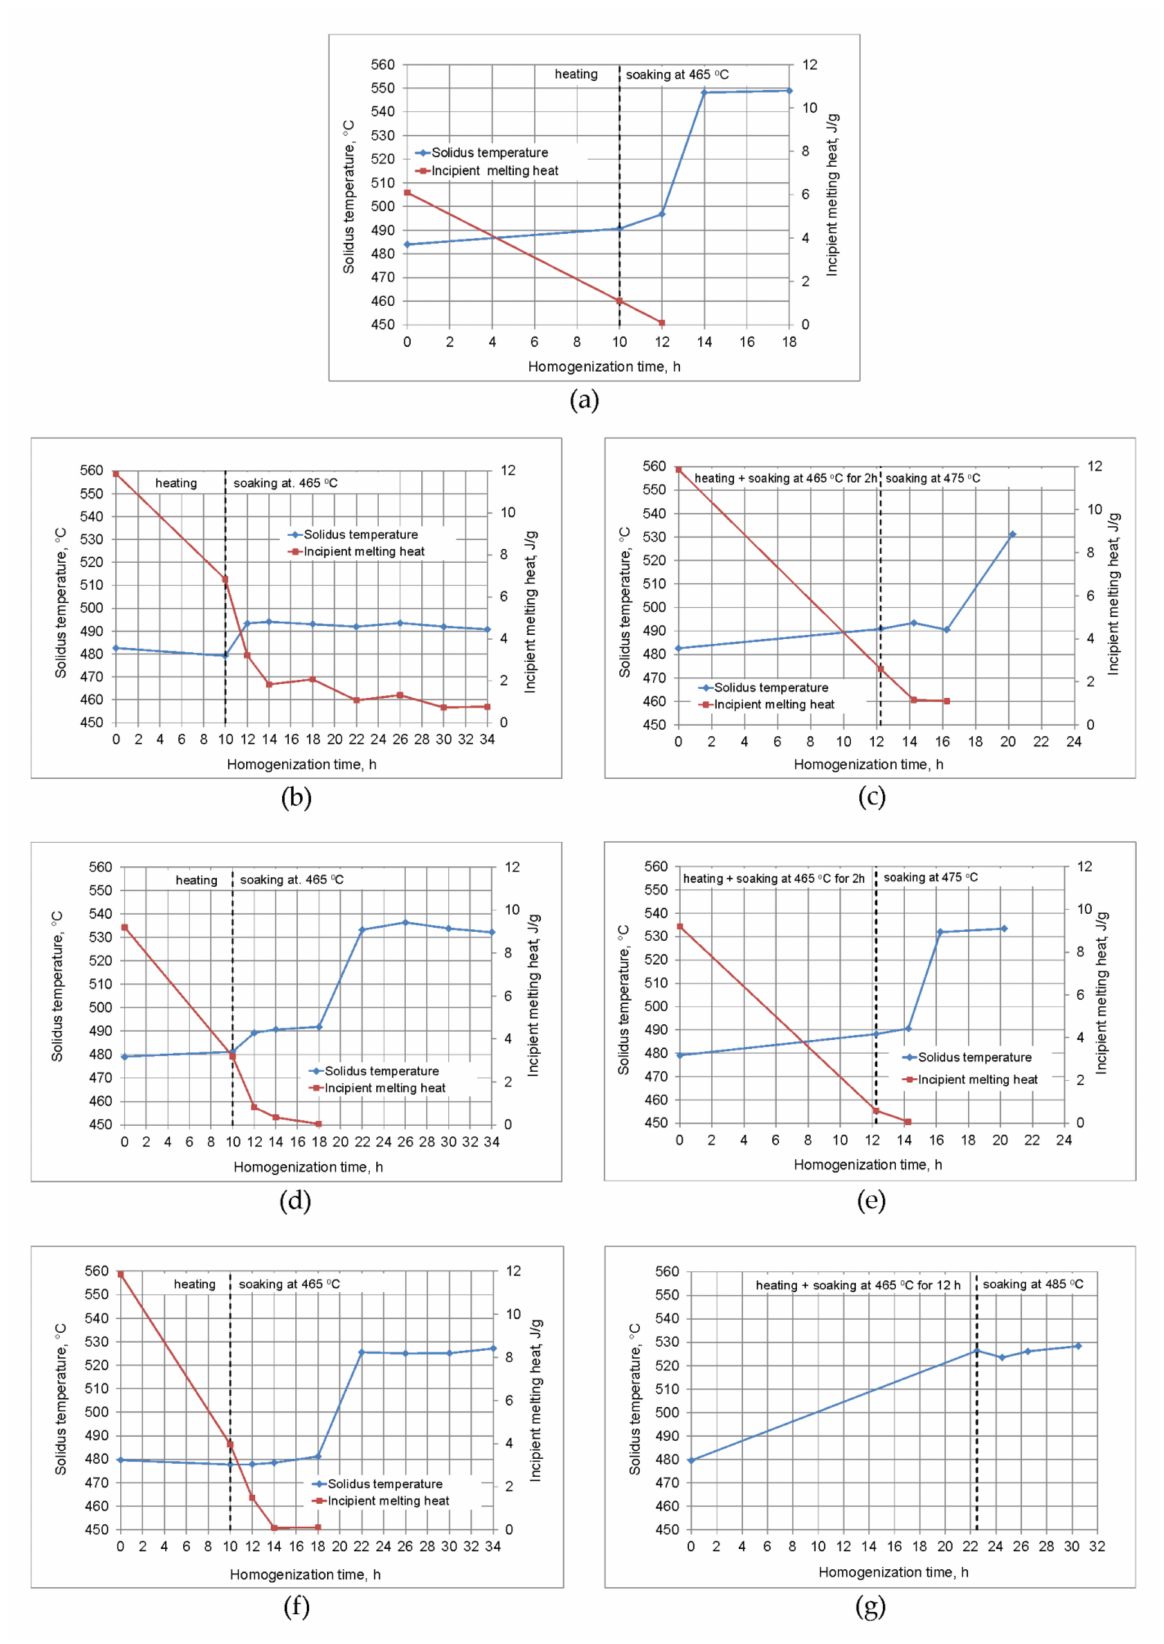
Figure 5. Changes of solidus temperature and incipient melting heat in the course of homogenization: ( a ) 7075 alloy 1; ( b , c ) 7075 alloy 2; ( d , e ) 7075 alloy 3; ( f , g ) 7049 alloy 4. Tables S1–S4 with determined values given in Supplementary